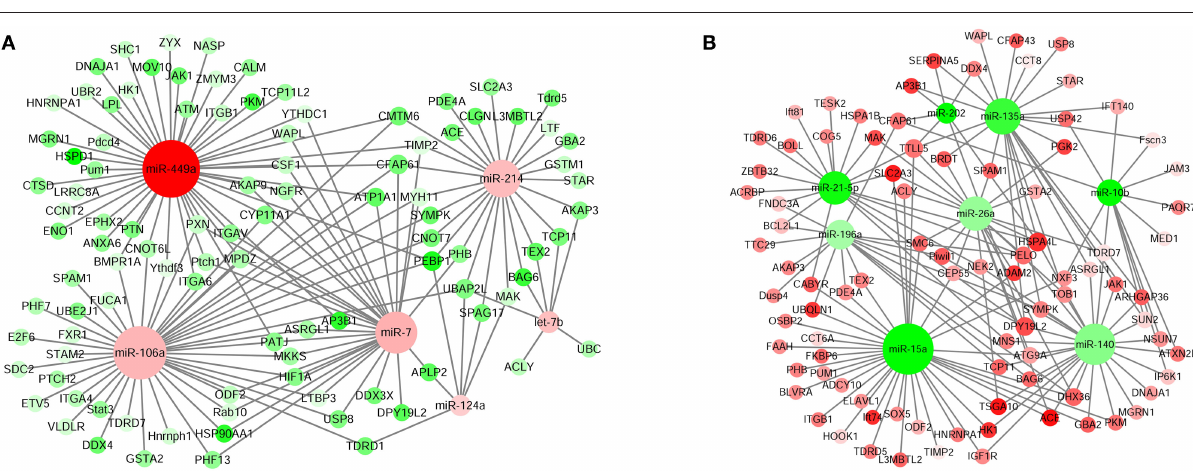
FIGURE 5 | miRNA-mRNA interaction network related to spermatogenesis of Sika Deer. (A) Up-regulated miRNAs and down-regulated target genes related to spermatogenesis. (B) Down-regulated miRNAs and up-regulated target genes related to spermatogenesis. The up-regulated miRNAs or genes were displayed as red circle, and the down-regulated miRNAs or genes were displayed as green